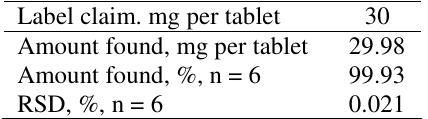
Table 3. Results from analysis of aripiprazole in